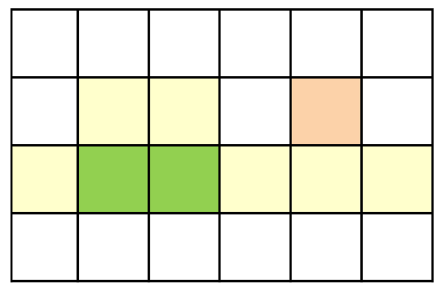
Figure 8. A part of extracted shoulder line.